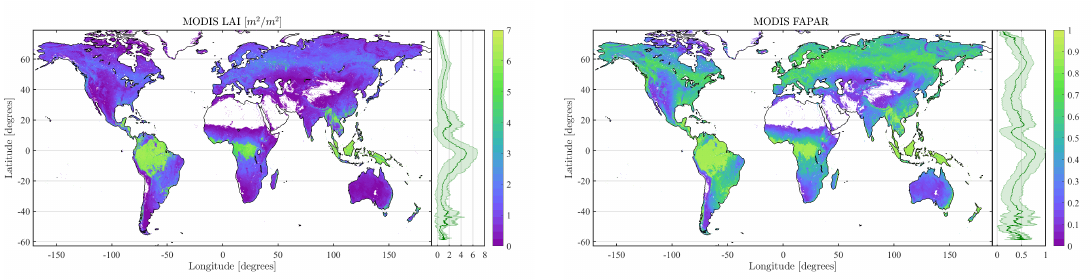
Figure 5. LAI and FAPAR global maps and latitudinal transects corresponding to the mean values of the GEE MODIS reference product (MOD15A3H) for the period